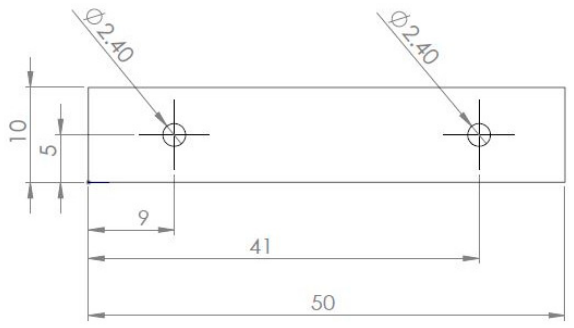
Figure 3. Detail drawing of CF / PEEK samples measuring 50 mm long, 10 mm wide and 2 mm thick.